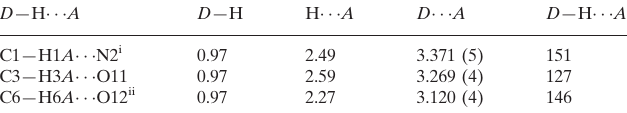
Data collection Bruker SMART APEXII CCD diffractometer